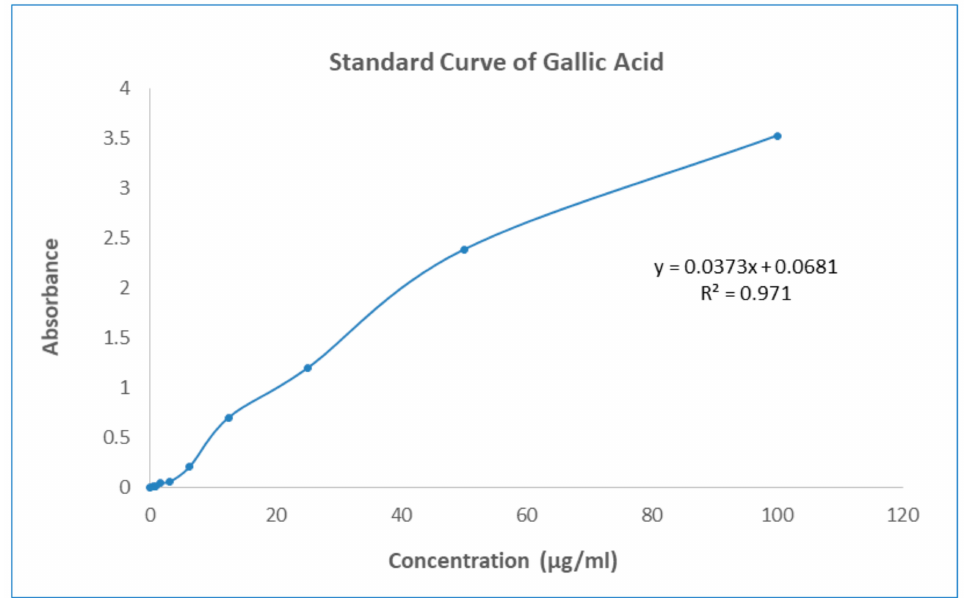
Figure 2. Standard curve of Quercetin.